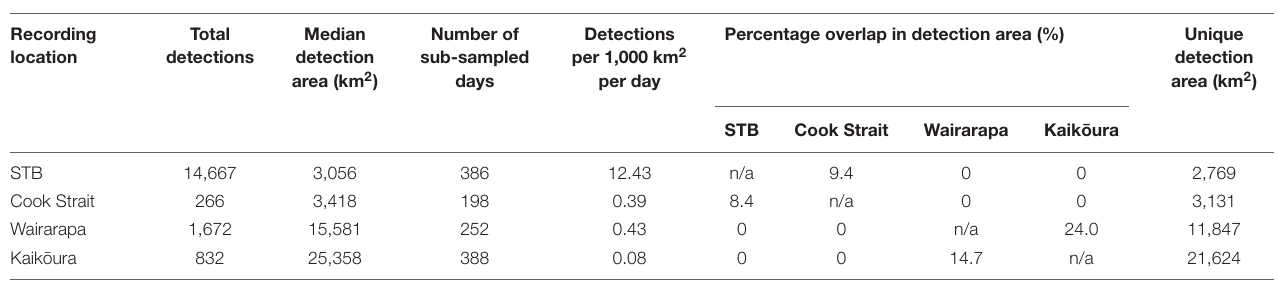
TABLE 2 | Pygmy blue whale call detections per recording location, and detection area information. Recording